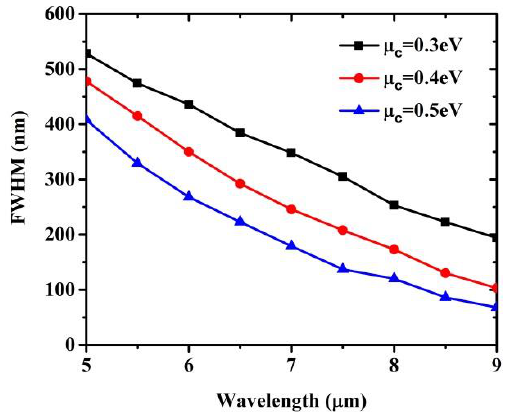
Figure 5. The full width at half maximum of the Talbot effect image’s intensity as a function of incident wavelength and chemical potential .